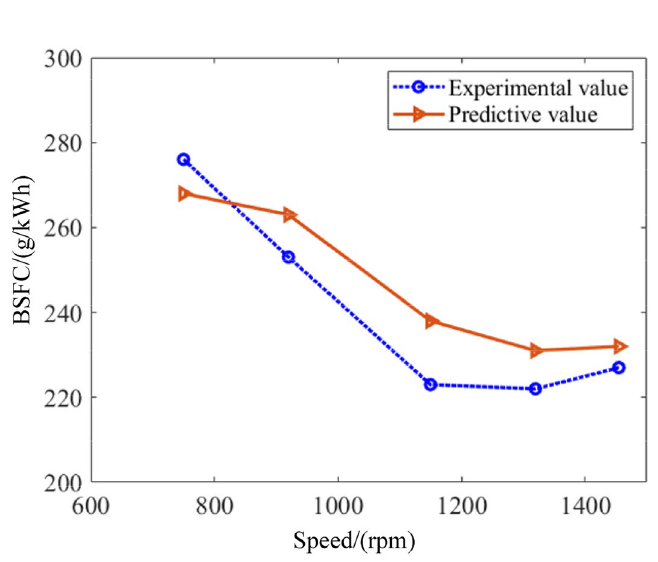
Figure 10. Comparison of brake specific fuel consumption between predictive and experimental